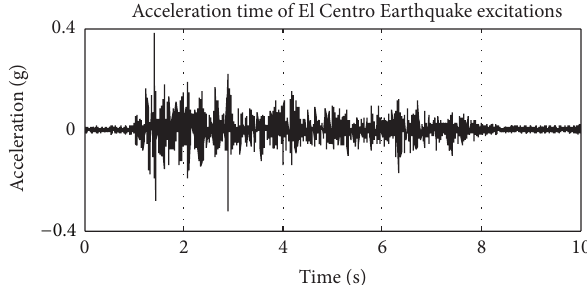
Figure 3: Time histories of scaled El Centro Earthquake.